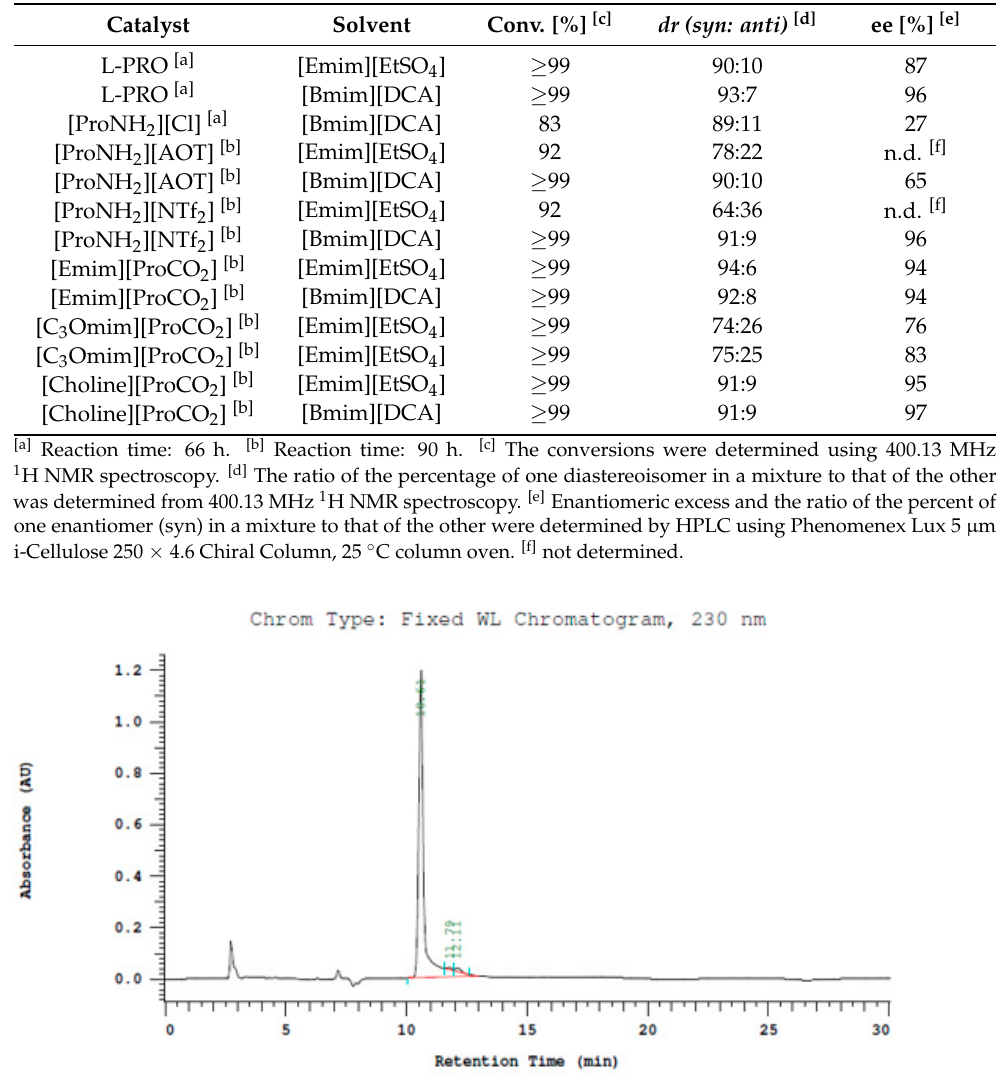
Table 3. Michael addition of cyclohexanone to trans-nitrostyrene catalyzed by CILs based on L- proline (30 mol%) using ILs as solvent.